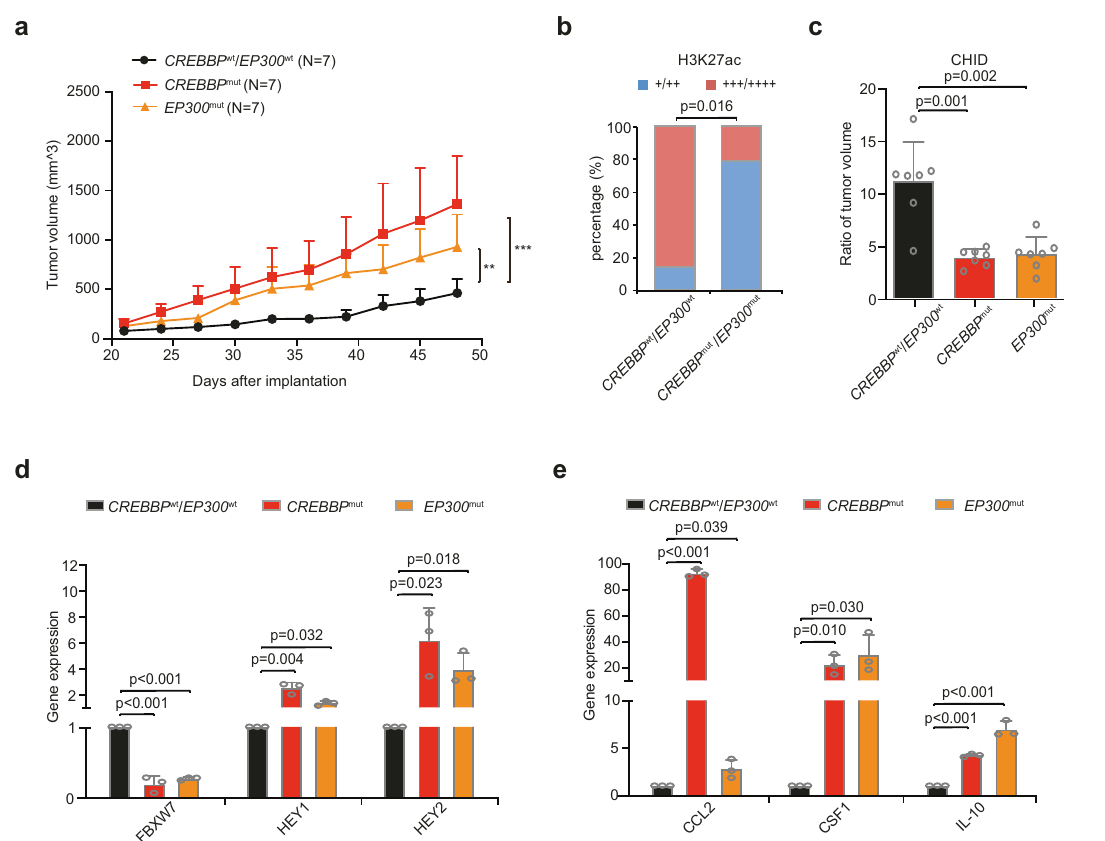
Fig. 7 CREBBP/EP300 mutations promoted macrophage polarization in murine patient-derived xenografted (PDX) models. a Tumor volume of PDX models injected subcutaneously with CREBBP Q929* or EP300 I997V tumor tissue from diffuse large B-cell lymphoma (DLBCL) patients. Error bars represent SD ( N = 7). ** P < 0.01; *** P < 0.001 comparing with those of CREBBP wt / EP300 wt . b Immunohistochemical assay of H3K27ac in CREBBP wt / EP300 wt and CREBBP Q929* / EP300 I997V tumors of PDX models. c Ratio of tumor volume of PDX models upon HDAC inhibitor chidamide (CHID) treatment (day 14 vs day 0). Data are presented as the mean ± SD ( N = 7). d Gene expression of FBXW7, HEY1 and HEY2 derived from PDX models with or without CREBBP / EP300 mutations by quantitative RT-PCR. Data are presented as the mean ± SD ( N = 3). e Gene expression of CCL2, CSF1 and IL-10 derived from PDX models with or without CREBBP / EP300 mutations by quantitative RT-PCR. Data are presented as the mean ± SD ( N = Cell lines and reagents B-lymphoma cell line DB and SUDHL4 (obtained from American